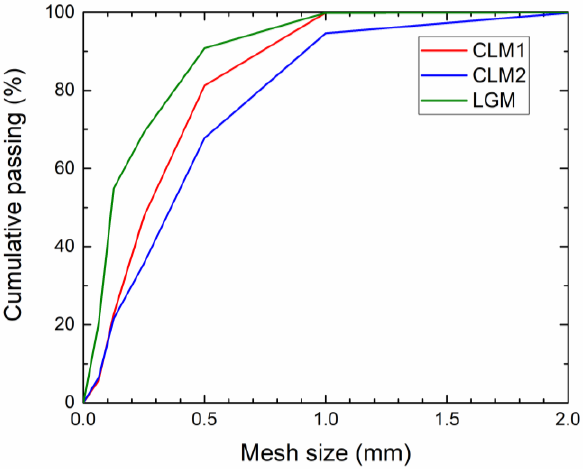
Figure 1. Particle size distribution of the analyzed plasters.